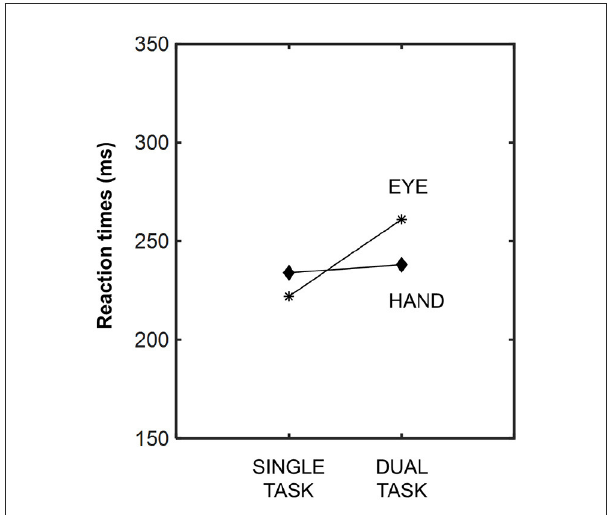
FIGURE1 Averaged latencies of eye and hand responses, measured in milliseconds, under both experimental conditions: single- and dual-task. Modified from Bekkering et al.